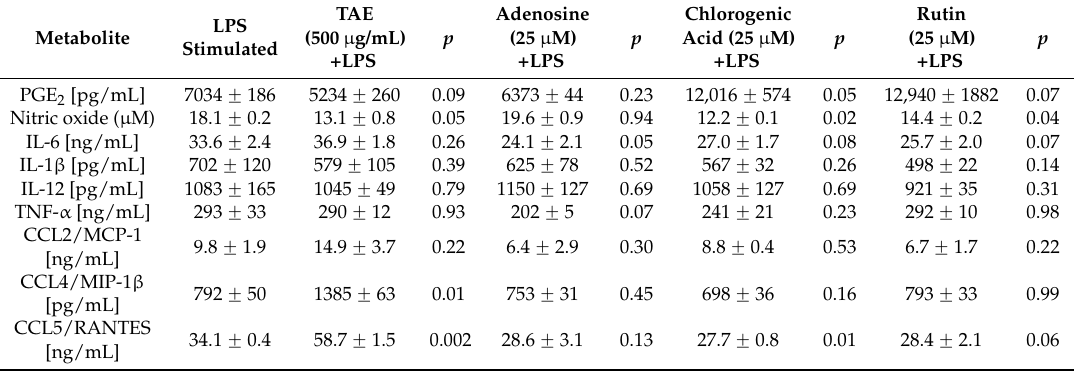
Table 1. Effects of constituents of TAE on the secretion of inflammatory metabolites by RAW264.7 macrophages. Cells were stimulated with LPS in the presence of the indicated substances and cultured for 24 h. Metabolites were determined in the culture supernatants by multiplex ELISA and Griess reaction (for nitric oxide). Representative data obtained in one of three different experimental series are shown. Mean values ˘ SD (of triplicate cultures) are